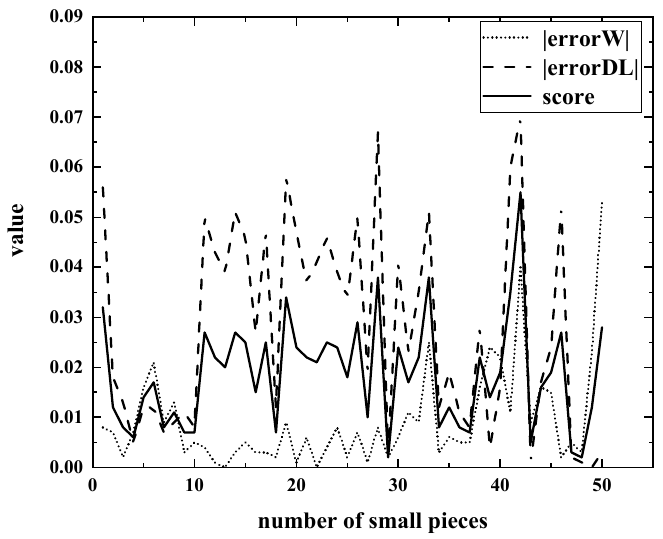
Figure 14. Comparison of | errorW |, | errorDL |, score. Table 5. Proportion of four types of data.